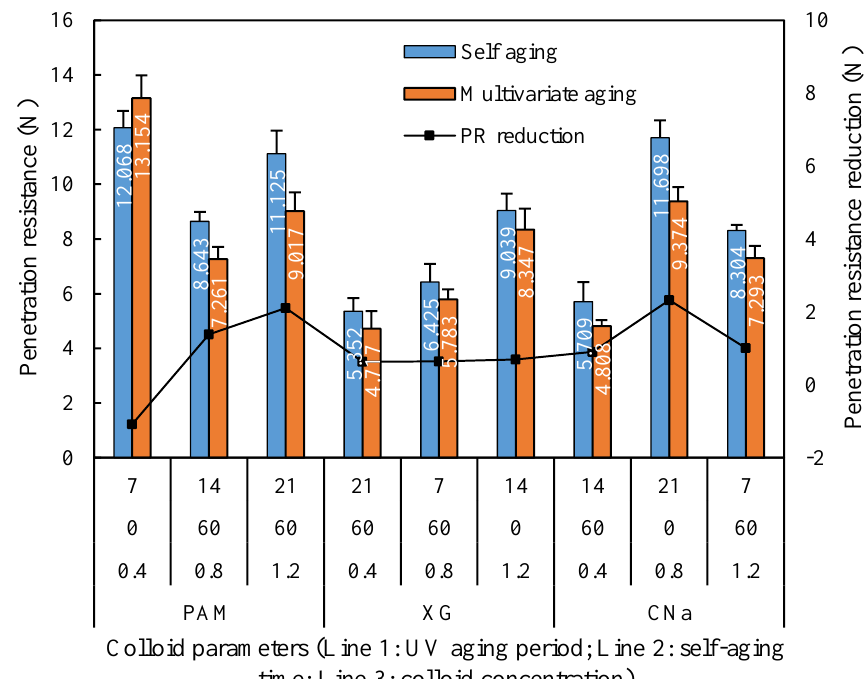
Figure 11. Penetration resistance reduction of UV aging test.